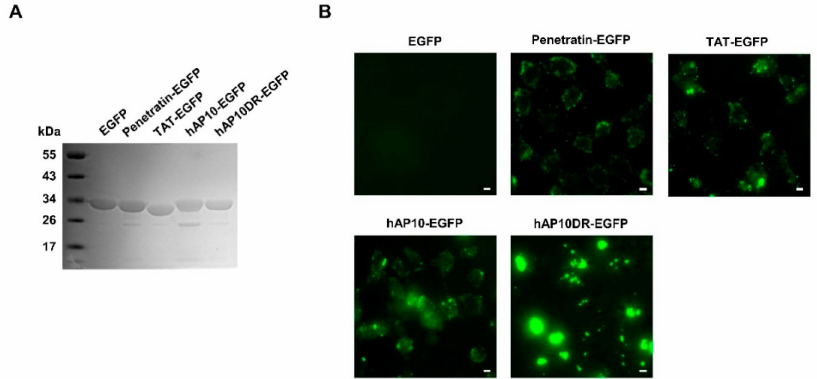
Figure 5. hAP10 and hAP10DR-mediated delivery of a GFP cargo into cells. ( A ) Electrophoretic analysis of the recombinant GFP derivatives. Samples (10 µ g) of the indicated purified recombinant proteins were resolved by SDS-polyacrylamide gel electrophoresis followed by Coomassie Brilliant Blue staining. ( B ) U2OS cells were exposed to the indicated GFP fusion proteins (5 µ M) for 1 h. Cells were then washed with PBS and live cells were imaged using fluorescence microscopy. All images were acquired using the same light intensity and microscope settings to permit direct comparison between the peptides. The scale bar indicates 10 µ